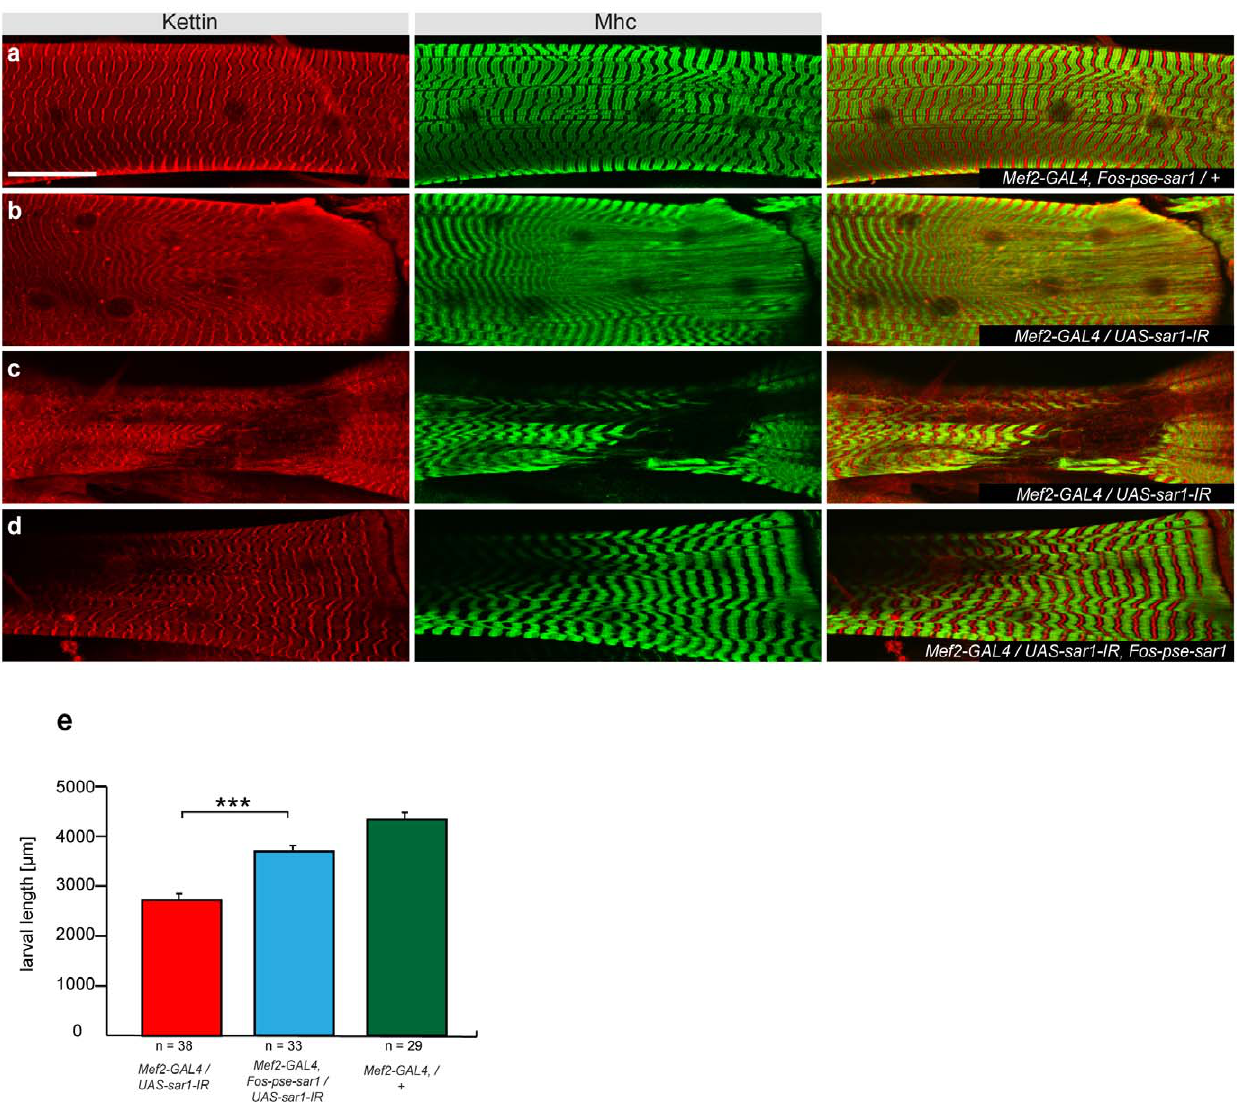
Figure 5. Phenotypic rescue of sar1 by D.pseudoobscura fosmid. ( a–d ) Fading Z- and M-line or loss of sarcomeres in Mef2-GAL4/UAS-sar1-IR (TF34191) ( b, c ) is rescued by FlyFos-pse-sar1 ( d ) to wild type ( a ). Z-lines are visualised with anti-Kettin (red), M-lines with anti-Mhc antibody (green); size bar corresponds to 50 m m. ( e ) Quantification of larval length in Mef2-GAL4/UAS-sar1-IR larvae (red), compared to FlyFos-pse-sar1 rescued (blue) and wild type (green). Larvae 72–96 h after egg laying were assayed. Error bars indicate standard error of the mean (SEM), ***p , 0.0001 (unpaired two-tailed t-test) compared to rescued larvae. doi:10.1371/journal.pone.0008928.g005 ing to Flybase. (b–g) Stage 16 (b–d) and stage 17 (e–g) wild-type (b, Figure S2 Mical mutant and RNAi phenotype Indirect flight muscles (a–d) and myofibrils of these IFMs (e–g) in wild type (a, e) Mical mutants (b, f), Mef2-GAL4/UAS-Mical-IR (TF25372) (c, g) and Mical mutants carrying the FlyFos-pse-Mical (d, h). Actin is visualised by phalloidin; size bar in (a–d) corresponds to 100 m m, Figure S4 Rescue of parvin knock-down. Larva of 48–72 h in (e–g) to 10 m m. (a–c) or 72–96 h (d–f) were imaged at the same magnification. Mef2-GAL4/UAS-parvinIR (TF11670) (a, d) stay tiny compared Figure S3 Cg25C and vkg genomic locus and collagen IV protein expression. (a) Screenshot of gbrowse representation of the genomic regions of D. melanogaster Cg25C and vkg; the position of the P-elements vkg 01209 and Cg25C k00405 are indicated accord-